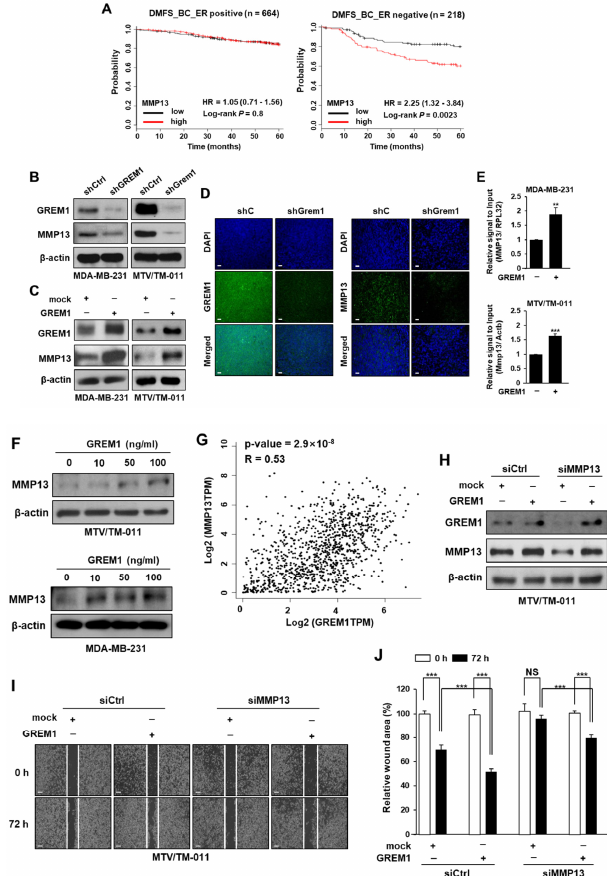
Figure 5 . GREM1 regulates the expression of MMPs in breast cancer cells. ( A,B ) Relative mRNA levels of MMPs in GREM1 -depleted breast cancer cells. ( C , D ) Relative mRNA levels of MMPs in GREM1 - overexpressing breast cancer cells. MDA-MB-231 and MTV/TM-011 cells were transfected with each indicated plasmid for 48 h, and mRNA levels of genes were quantitated by qPCR analysis. Data are presented as the mean ± SD of three independent experiments. Two-sided t -test. *, p < 0.05; **, p < 0.01; ***, p < 0.001; NS, not significant.